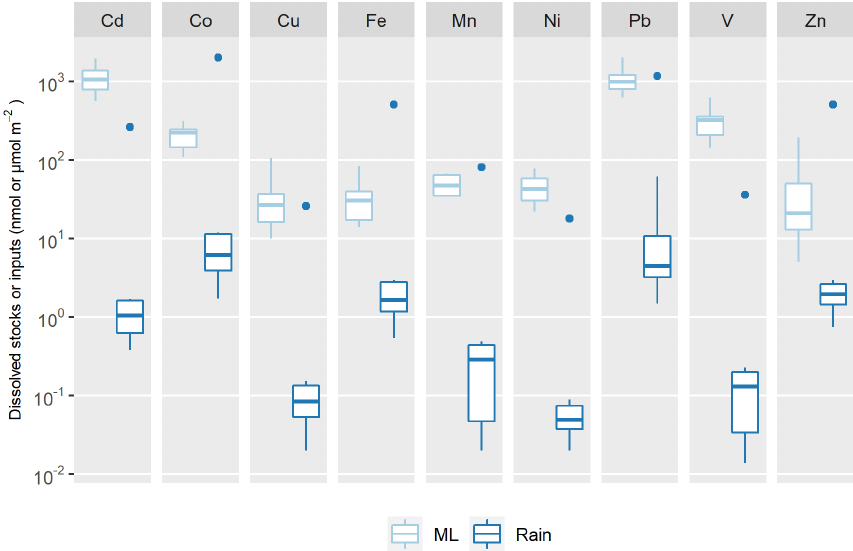
Figure 10. Comparison of marine stocks in the ML at all the stations occupied during the PEACETIME cruise (light blue boxes) with atmospheric deposition fluxes estimated from ION and FAST rains (dark blue boxes) and from an intense wet dust deposition event of 9gm − 2 (blue dots). Cd, Co and Pb stocks and fluxes are given in units of nmolm − 2 , and the other TMs are given in units of µmolm − 2 . For Mn, marine stocks are derived from surface concentrations close to the coast of Corsica (OUT samples at 0, 5 and 10m from Wuttig et al., 2013) and in the Ionian Sea (Bannock Basin samples at 0, 10 and 15m from Saager et al., 1993) as no measurements are available from the PEACETIME cruise. Boxes and whiskers as the same as in Fig.